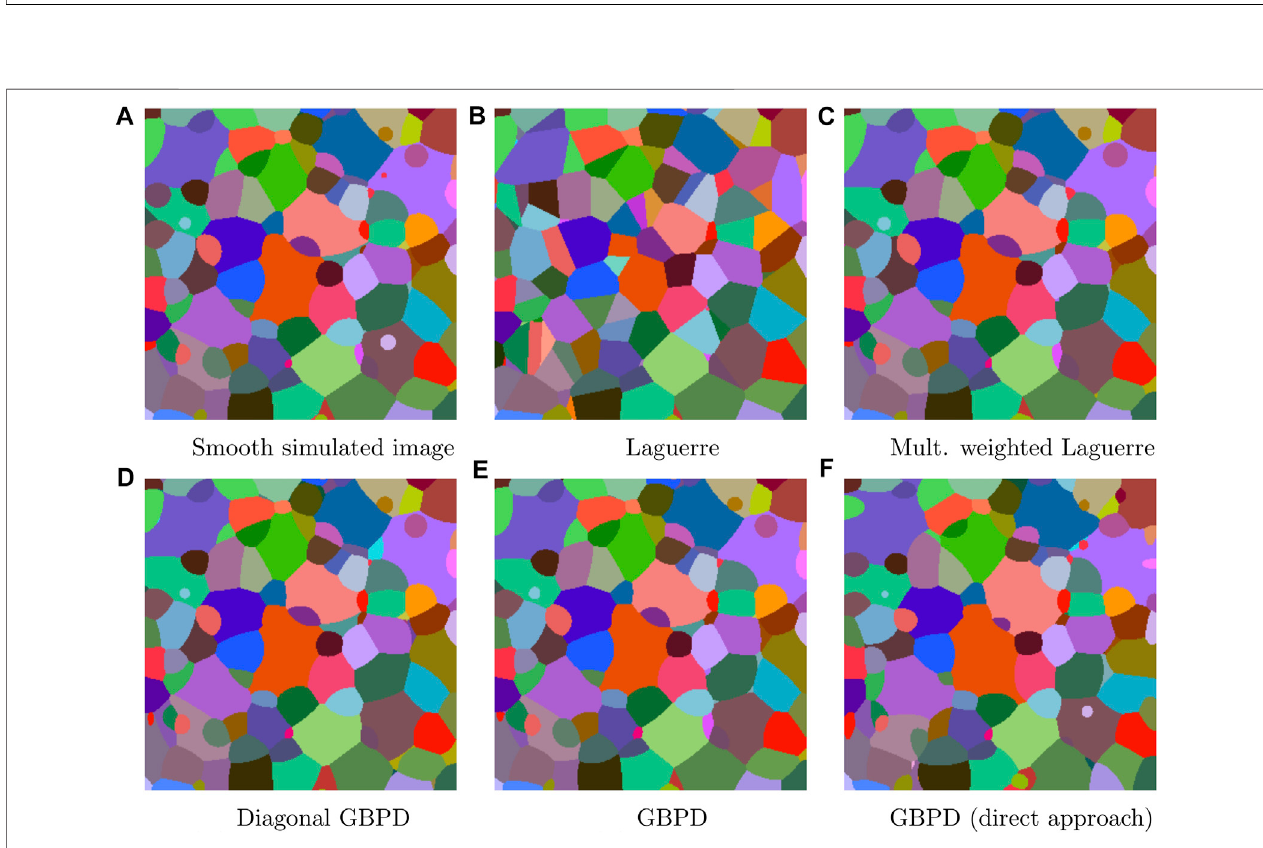
FIGURE7| Fractionofcorrectlyassignedvoxelsplottedagainsttheperturbationspread σ ,evaluatedforallvoxelsintheimagedatasetandfortheboundaryvoxels.